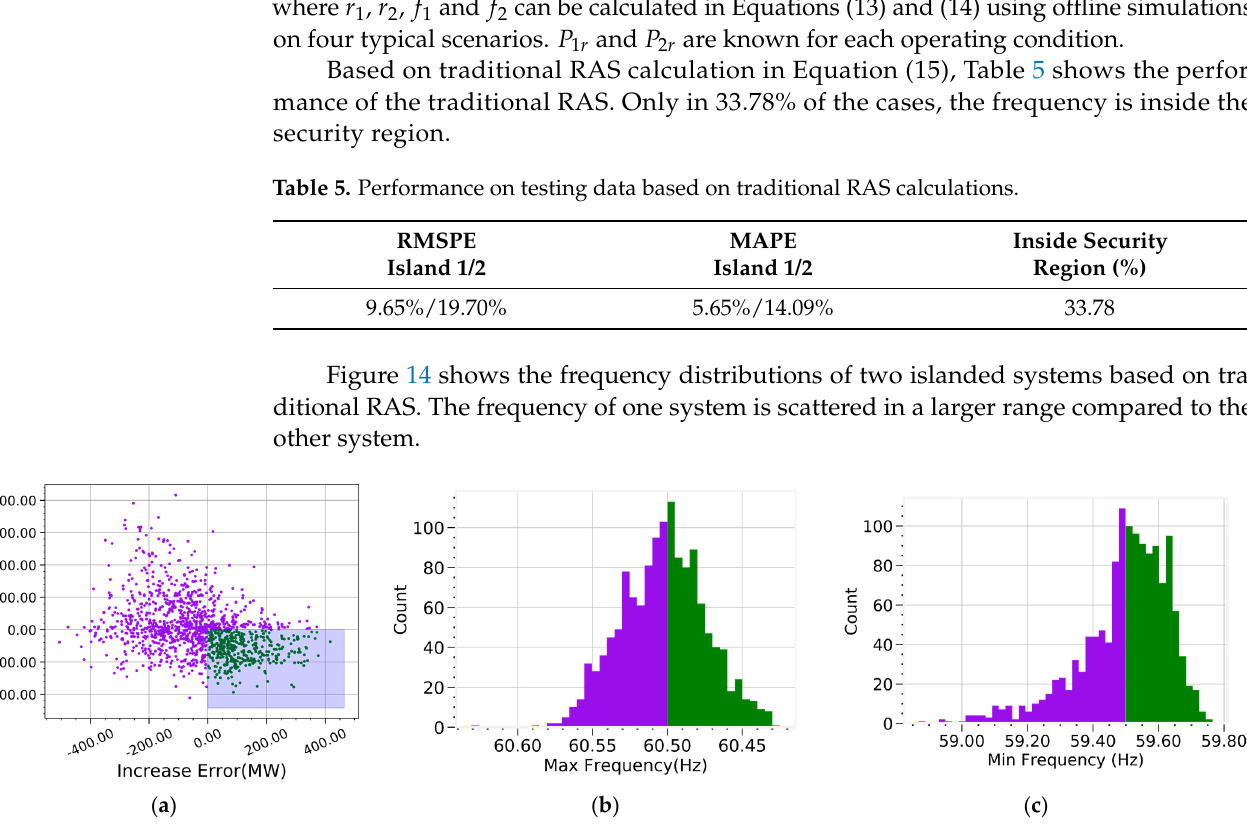
Figure 14. Maximum and minimum frequency and histograms of Island 1 and Island 2: Traditional RAS (purple: outside secure region, green: inside secure region, shaded area: secure region). ( a ) Max. and Min. frequency; ( b ) Max. frequency histogram in Island 1; ( c ) Min. frequency histogram in Island